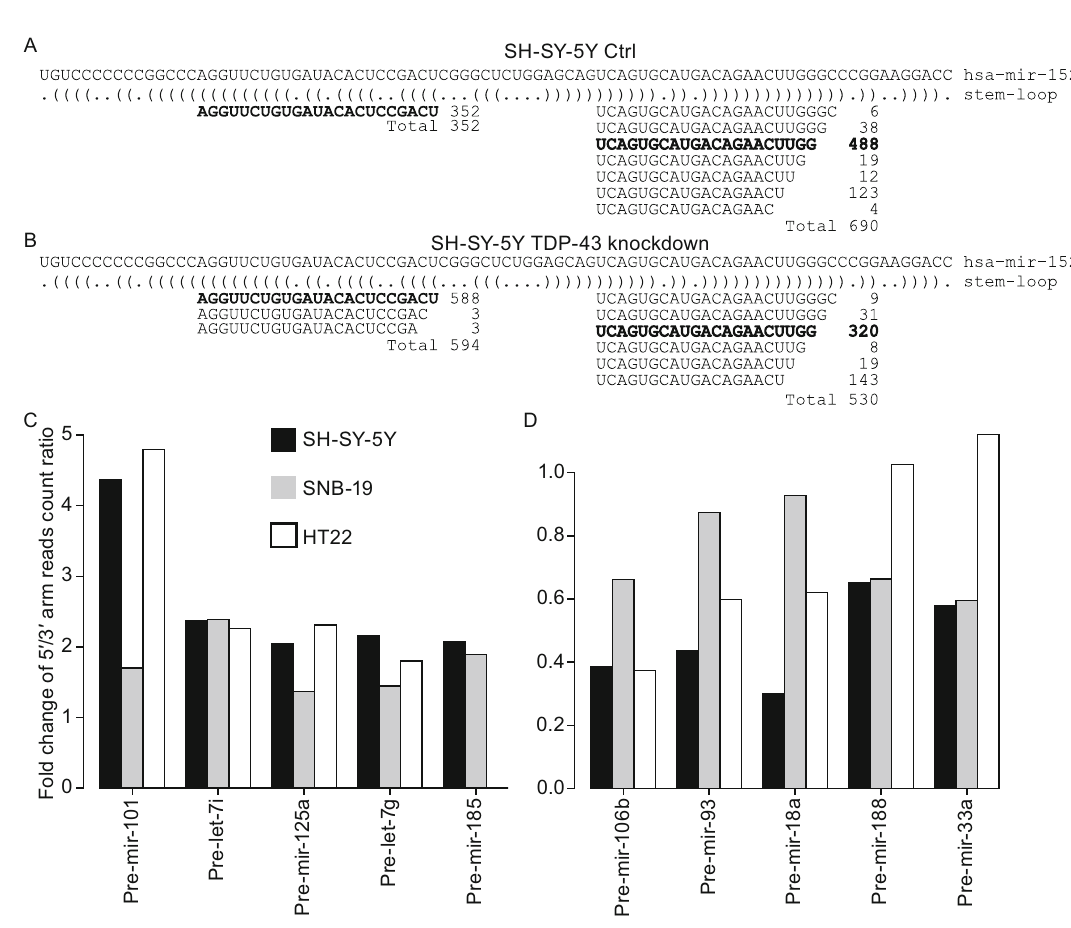
Figure 3. Reads mapping to hsa-mir-152 and changes of 5 ′ /3 ′ arm reads count ratio following TDP-43 knockdown. Reads mapping to 5 ′ and 3 ′ arm of hsa-mir-152 in SH-SY-5Y control cells (A) and TDP-43 knockdown cells (B), mature miRNA sequences from both arms in bold. (C and D) Pre-miRNAs with more than 1.5 fold increase (C) or decrease (D) in 5 ′ /3 ′ arm reads count ratio in at least two cell lines after TDP-43